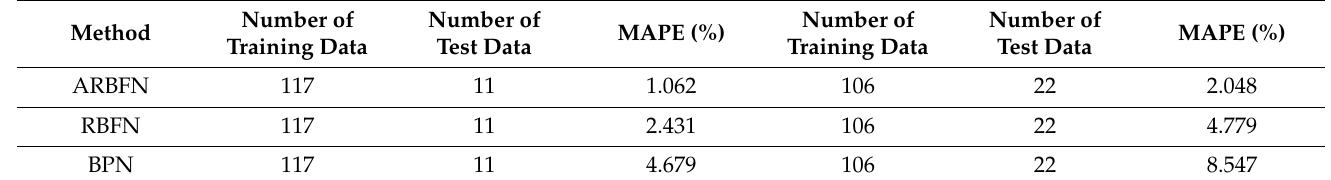
Figure 4. Chiller NO.3 on ARBFN. Table 2. Performance comparison with various control methods in the NO.3 chiller net.